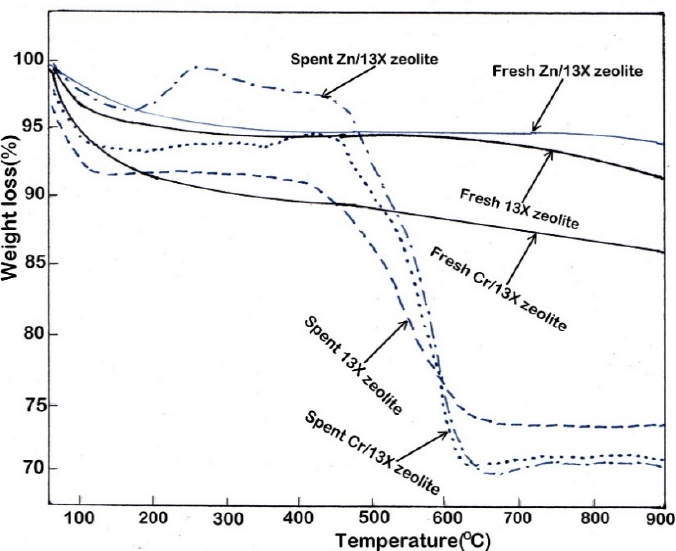
Figure 11. Weight loss of fresh catalysts and spent catalysts, rate of heating of 10 °C/min, in air atmosphere, flow rate of 100 mL/min.